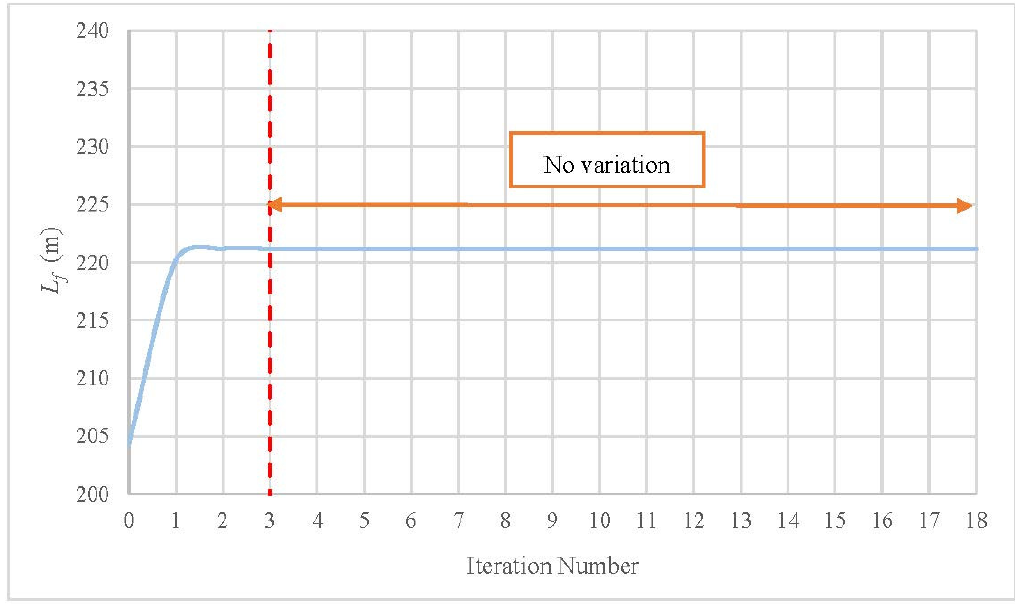
Figure 5. Final water column length versus iteration number .